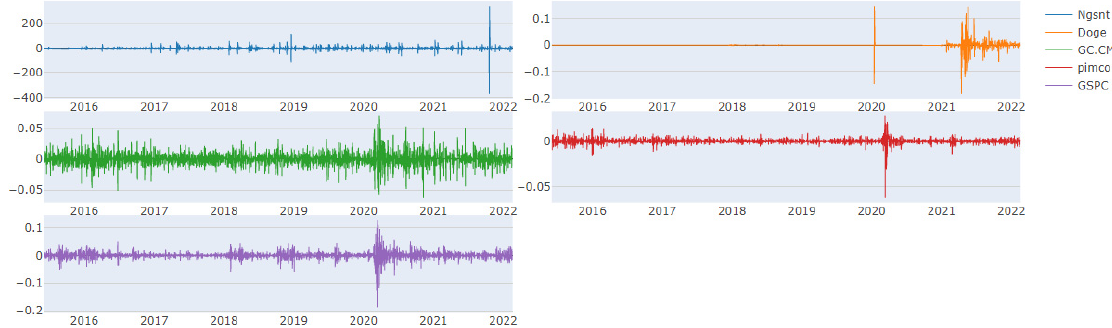
Figure 2. Transformed data representing all the five variables.